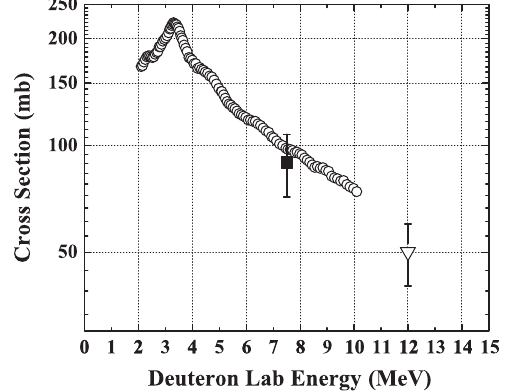
FIG. 26. 8 Li production cross section compared with known data. Full square: present experiment; empty circles from Ref. [49]; empty triangles from Ref. [48]